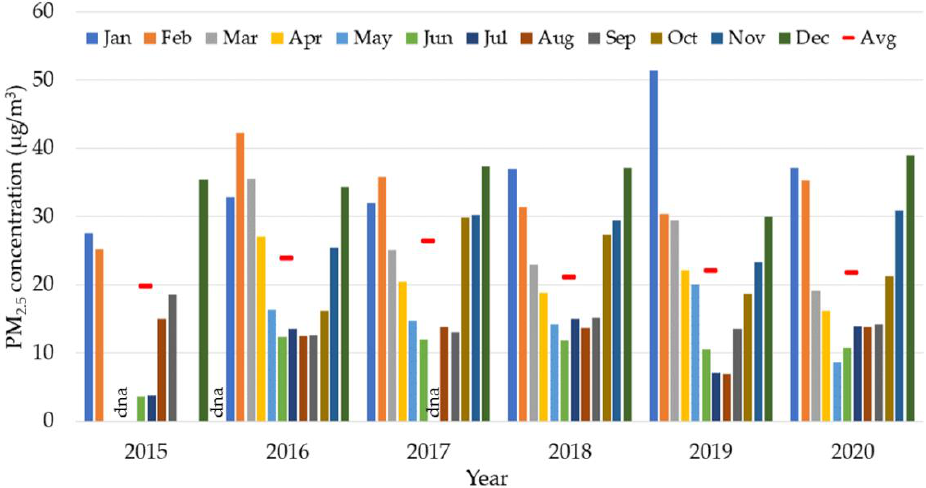
Figure 2. Monthly averages (vertical bars) and annual averages (horizontal bars) of PM 2.5 concentrations from 2015 to 2020 measured at Kasetsart University using TEOM.